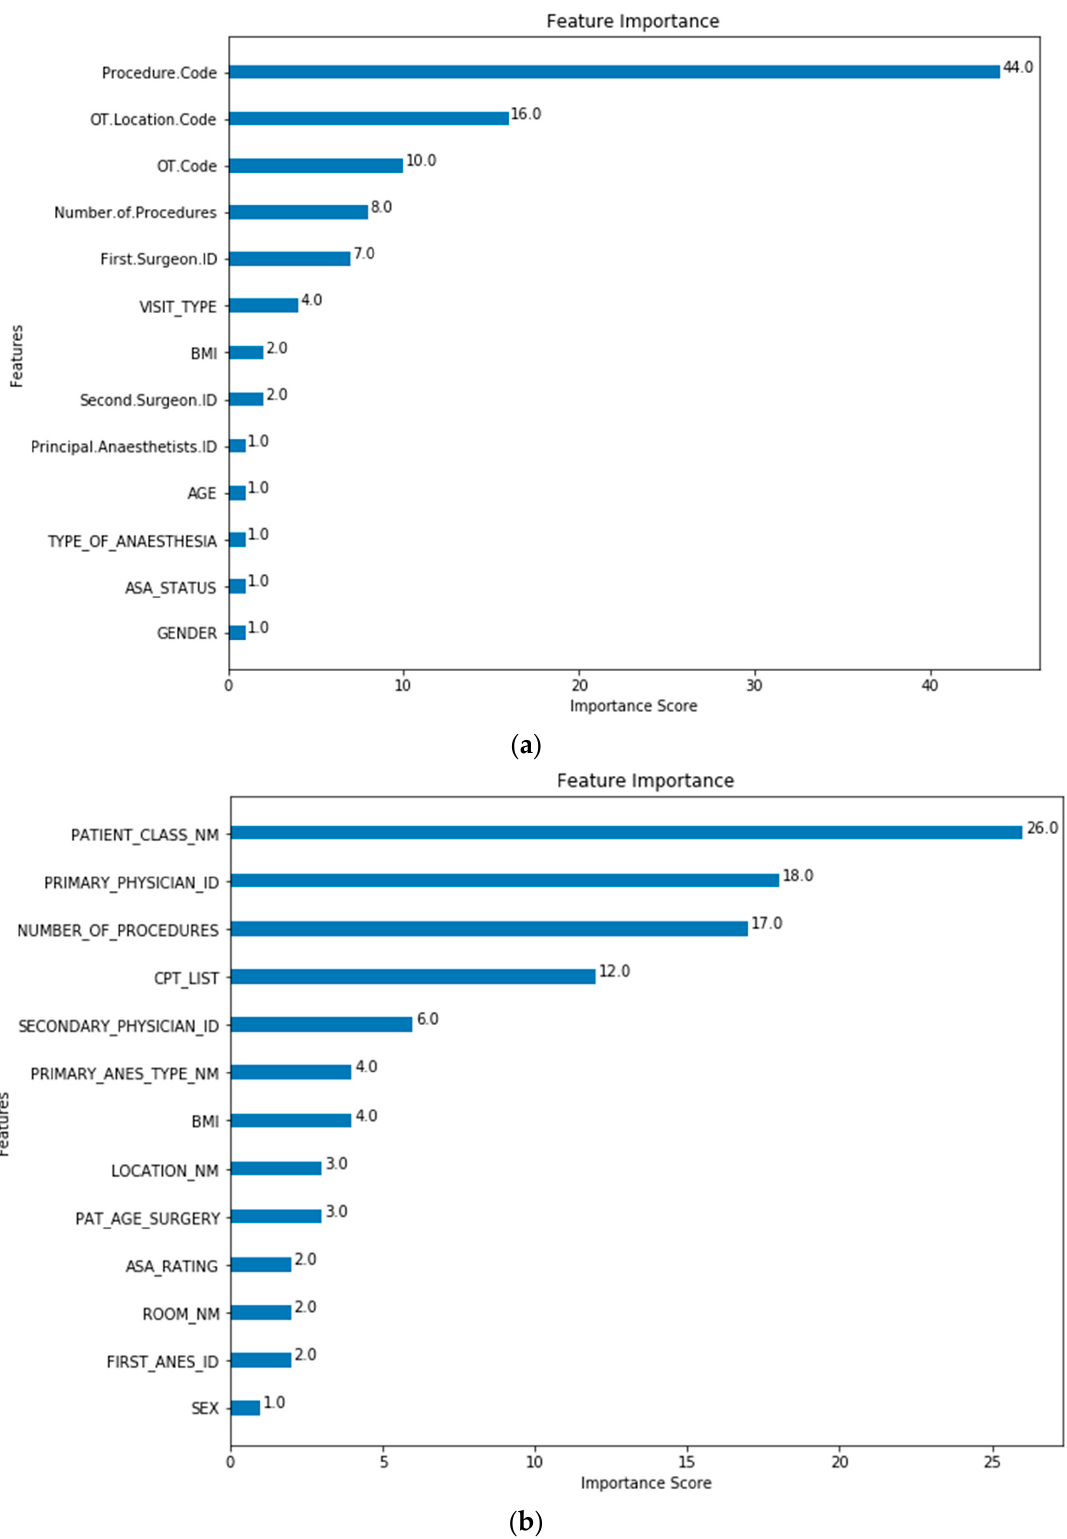
Figure 3. Model 0 Feature Importance for ( a ) SH-1; ( b ) SH-2. (Note: Refer to Table 1 for feature mapping between SH-1 and SH-2).